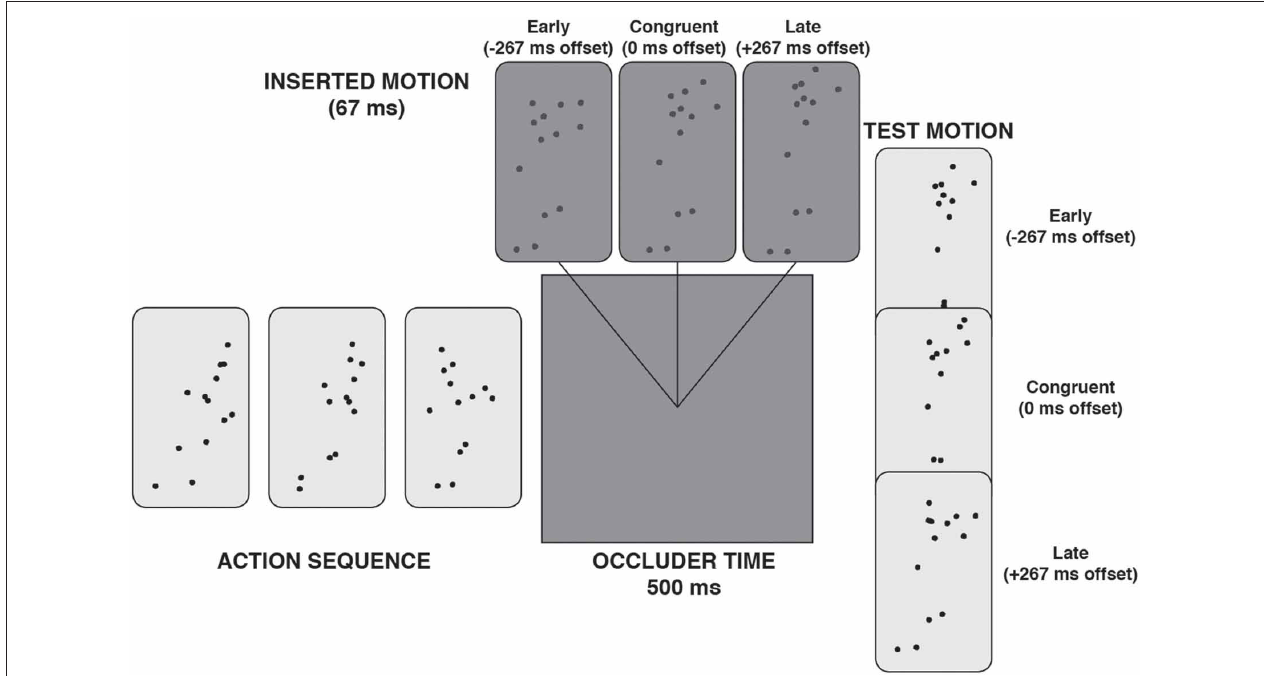
FIGURE 3 | A schematic illustration of a trial with “inserted motion” during the occlusion phase.